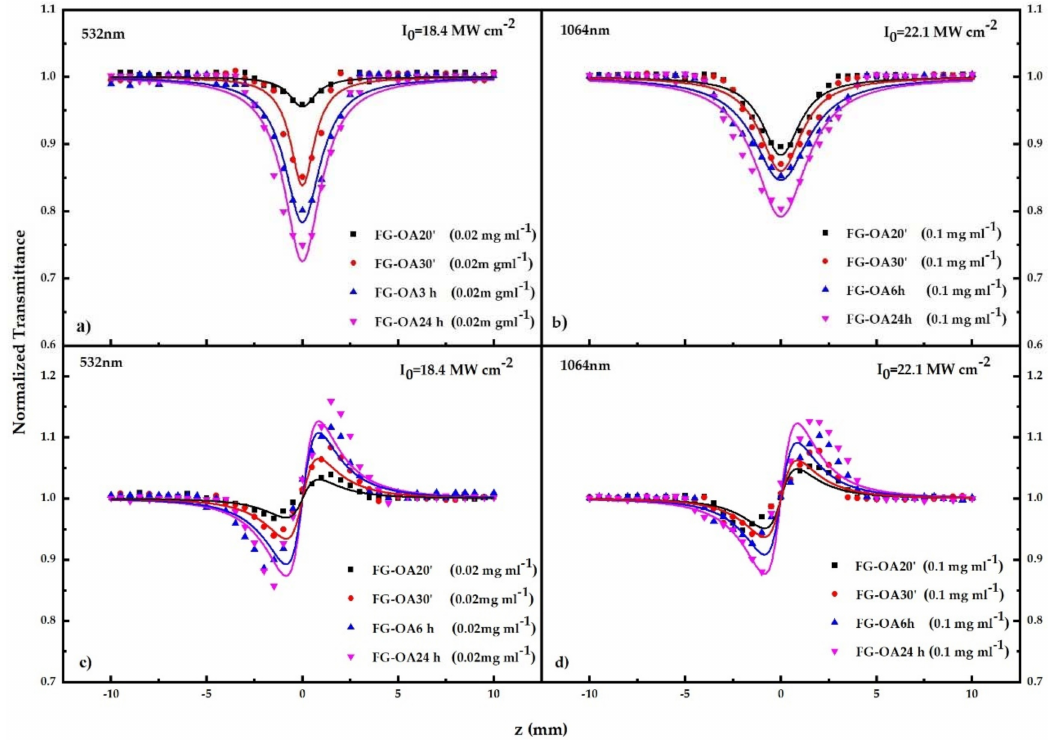
Figure 2. ( a , b ) “Open-aperture” (OA) and ( c , d ) “divided” (CA) Z-scans obtained under 4 ns 532 and 1064 nm laser